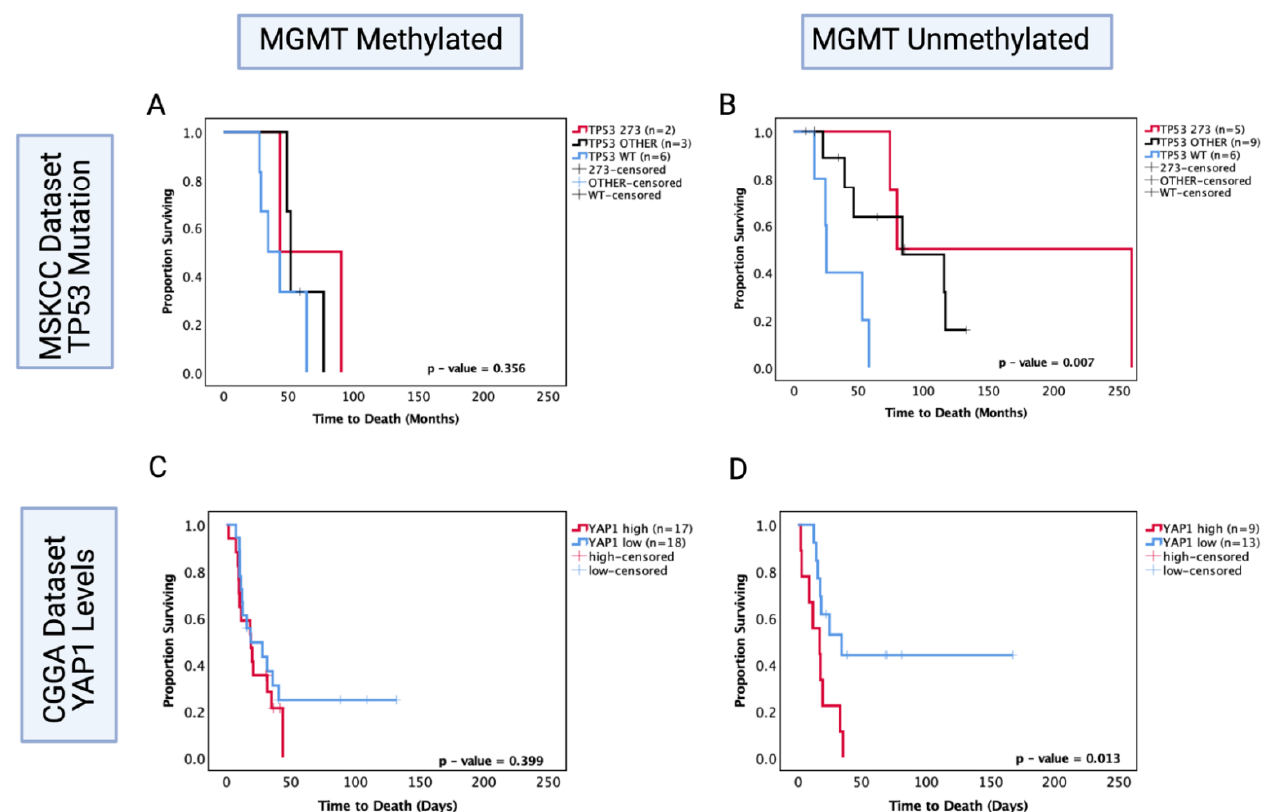
Figure 9. Kaplan–Meier survival curves comparing effects of TP53 mutation status on the OS of chemotherapy-treated ( A ) MGMT methylated and ( B ) MGMT unmethylated astrocytoma in the MSKCC dataset. Kaplan–Meier survival curves comparing the effects of YAP1 mRNA expression levels on the OS of chemotherapy-treated ( C ) MGMT methylated and ( D ) MGMT unmethylated astrocytoma in the CGGA dataset. TP53 273: TP53 codon 273 mutant, TP53 OTHER: all pathogenic TP53 mutations except in codon 273, TP53 WT: wild-type TP53 status. Log-rank test was used for analysis and a p -value < 0.05 for statistical significance.